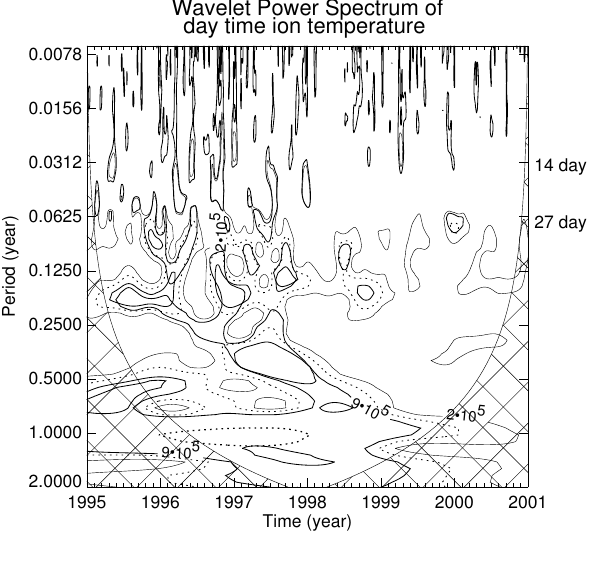
Fig. 13. Wavelet spectra of A p during 1995–2000. Other details are same as in Fig. 1.